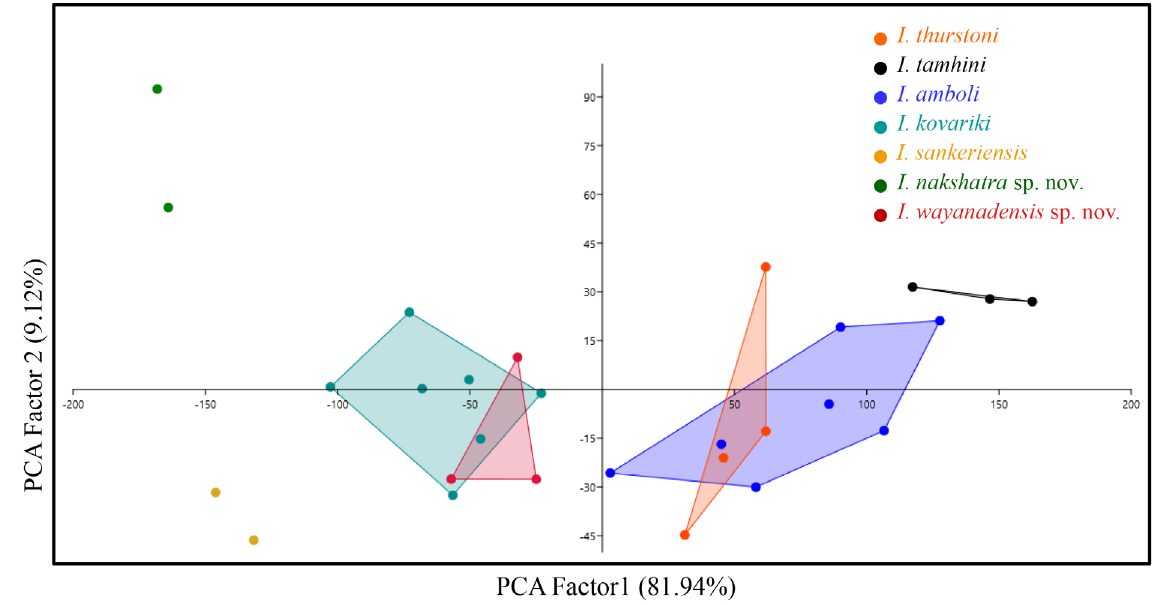
Fig. 3. Projection of first two Principle Component factors explaining 91.06% of the variation among the seven species of the genus Isometrus Ehrenberg,